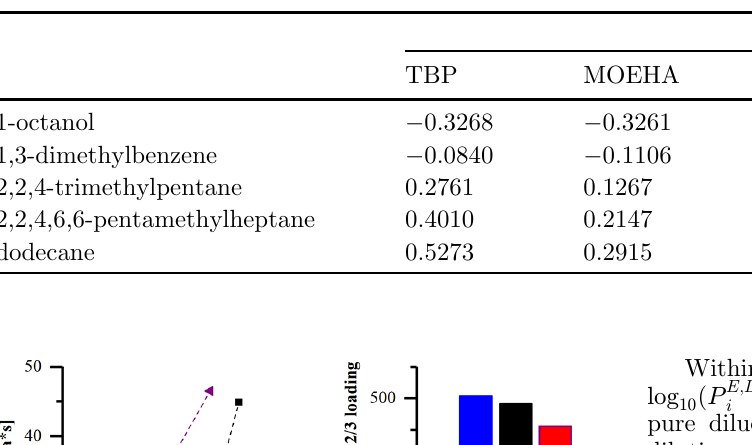
Table 2. COSMO-RS predicted in fi nite dilution partition coef fi cients of a diluent molecule i between a pure extractant and a pure diluent phase. All calculations were performed on the BP-TZVPD-FINE level at a temperature of 25 ° C with 7 conformers for TBP, 8 conformers for MOEHA, 9 conformers for DEHBA, 4 conformers for DEHiBA and 11 conformers for DEHDMBA. In order to calculate the thermodynamic partitioning, the volume fraction of both phases was set to